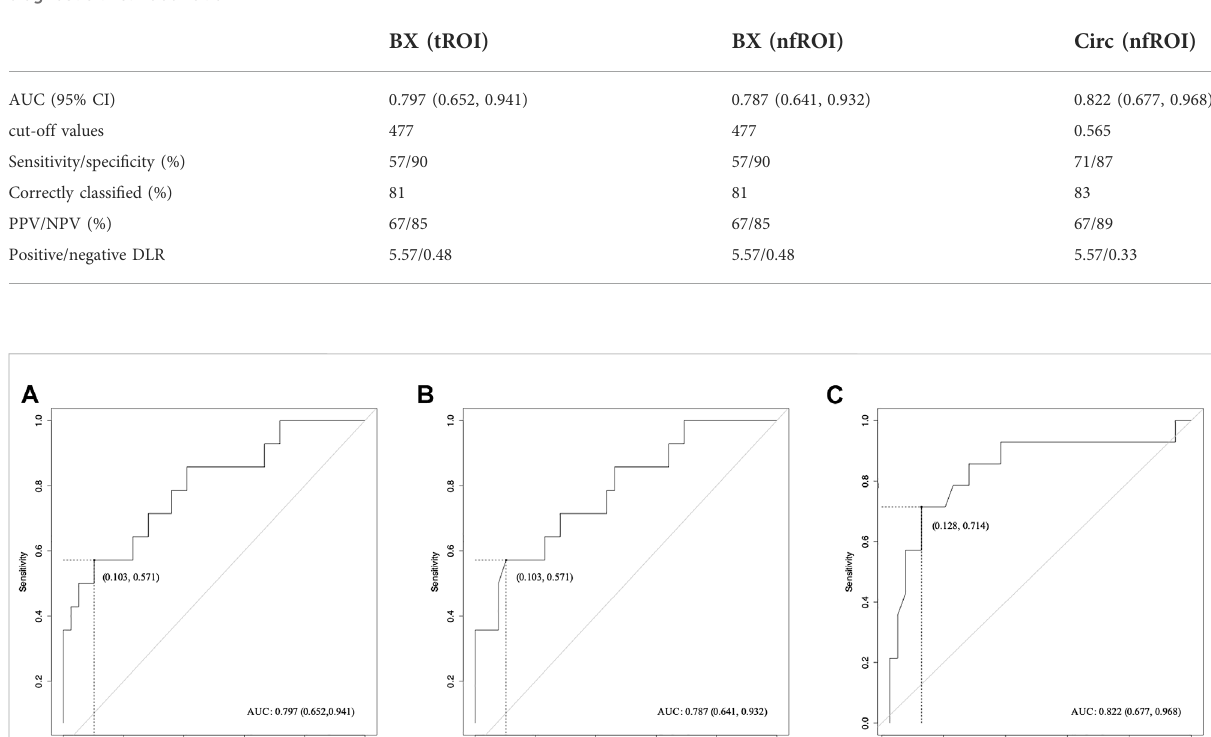
TABLE2DiagnosticperformanceofBX(tROI),BX(nfROI)andCirc(nfROI)forthepredictionofsonicationenergy.Thecut-offvaluesweredetermined atwhichthevalueoftheYoudenindexwasmaximized.tROI,areaofinterestoftumor;nfROI,areaofinterestofnear fi eld;AUROC,areaunderthe receiver operating characteristic curve; PPV, positive predictive value; NPV, negative predictive value; Positive/negative DLR, positive/negative diagnostic likelihood ratio.